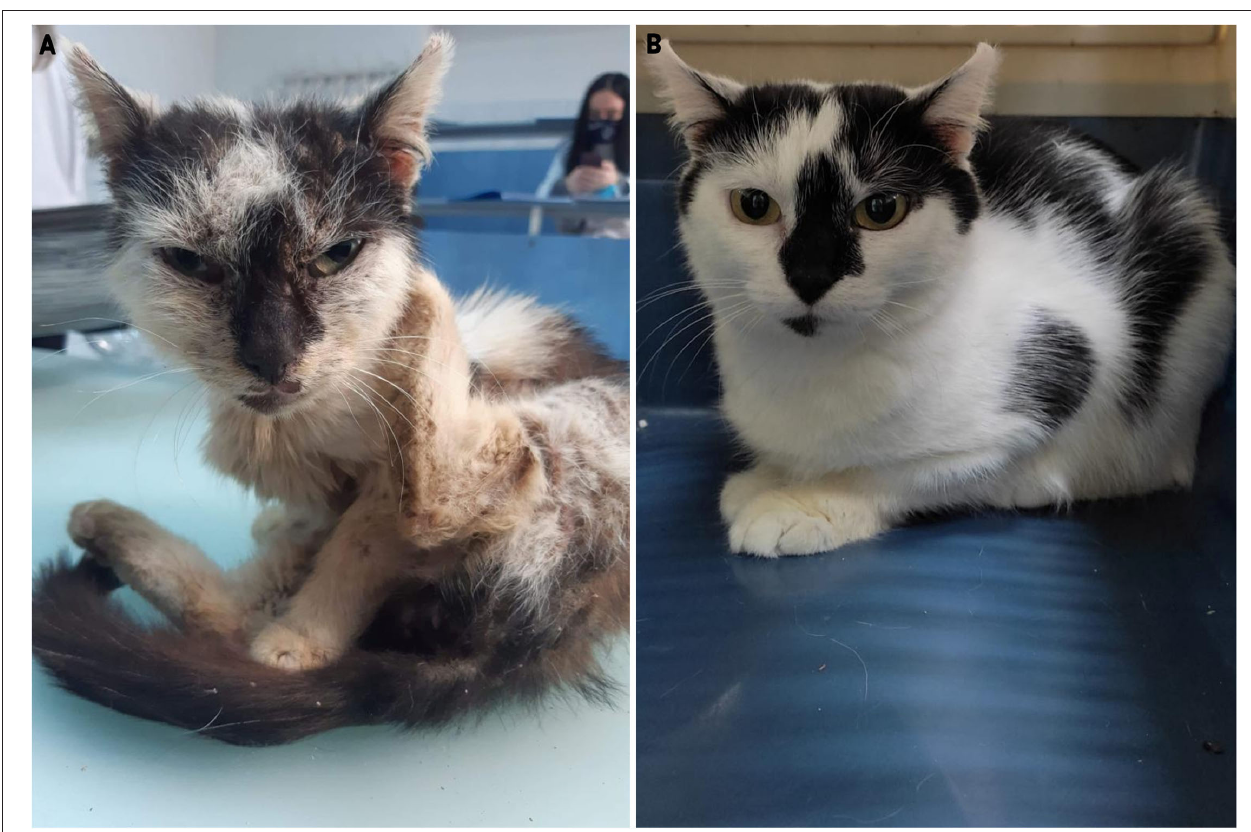
FIGURE 4 | Clinical aspect of the 20-month-old female cat (case 2) before (A) and after (B)